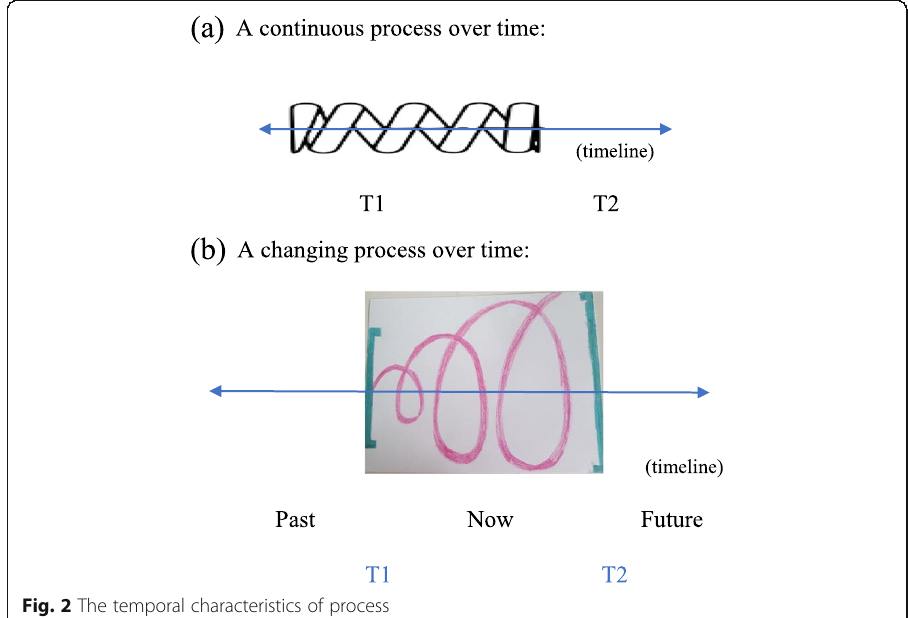
Fig. 2 The temporal characteristics of